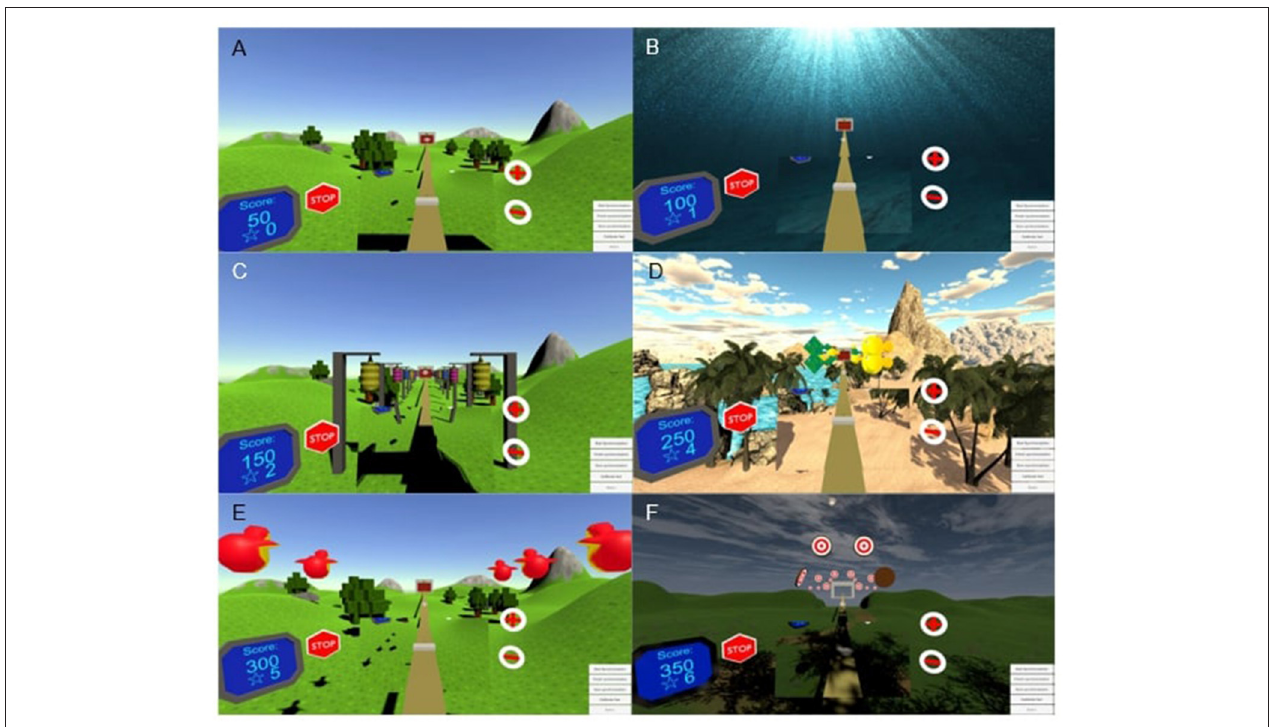
FIGURE 2 | (A–F) Screenshots from all six